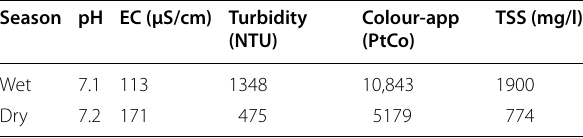
Table 2 Seasonal variation of water quality in R. Manafwa (intake for Mbale water